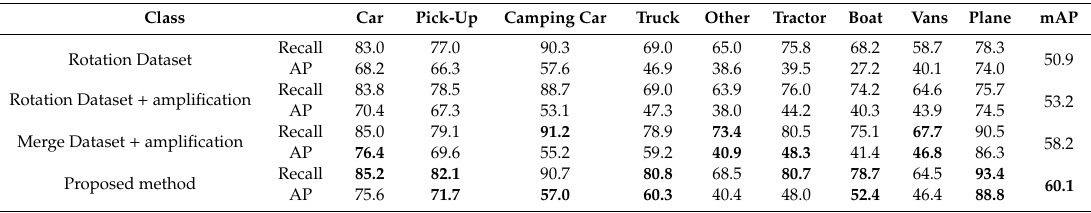
Table 9. The mean of ablation experimental results of OBB from two groups.